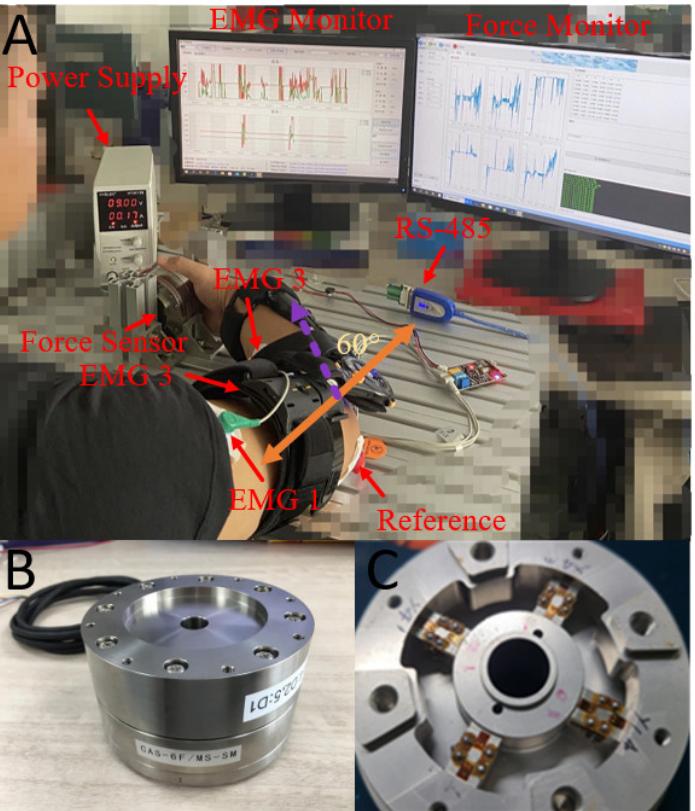
Table 3. Experiment procedures for each subject.